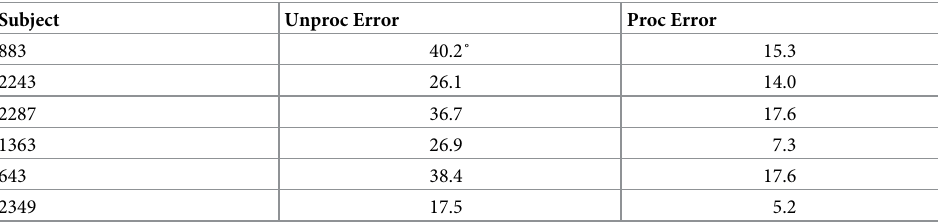
Table 3. There is one listener per row. Data show RMS error in degrees azimuth for the Unprocessed and Processed conditions.